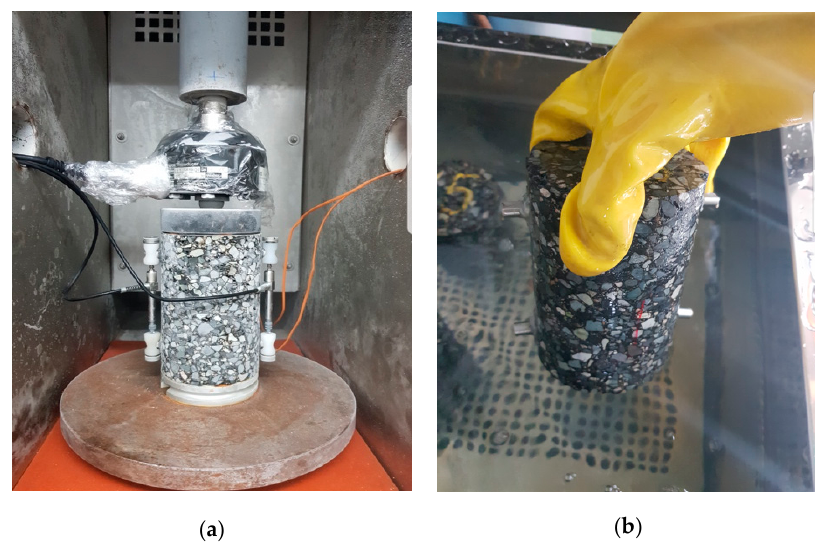
Figure 3. Specimen setup: ( a ) DM test; ( b ) moisture conditioning.